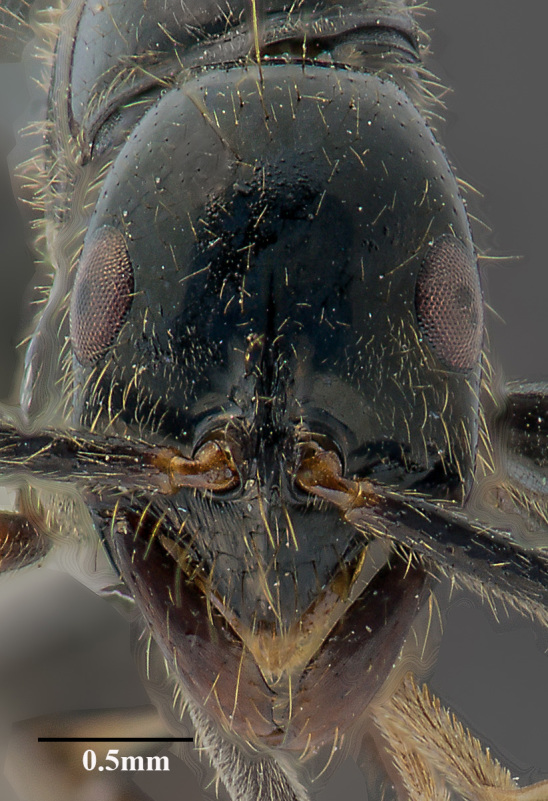
Head, full-face view